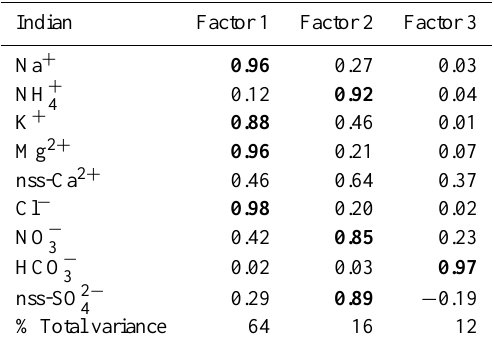
Table 5. Factor loadings and total variance identified in the Indian trajectory group. ∗ Bold font indicates that the factor loading is significant at 95%